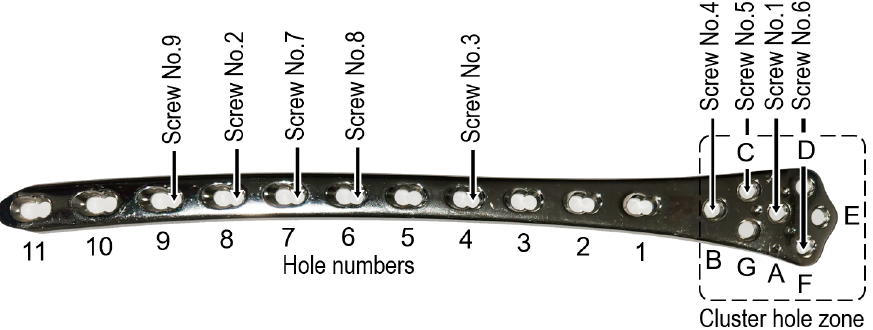
Figure 2. LISS-DF plate with an exemplified sequence of screw insertions into the plate